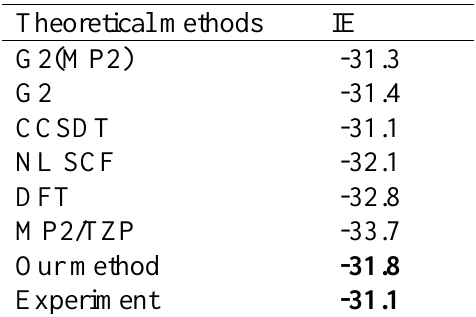
Table 5b : Comparison of the IE (in kcal/mol) of BH other high-level accurate quantum chemical calculations.